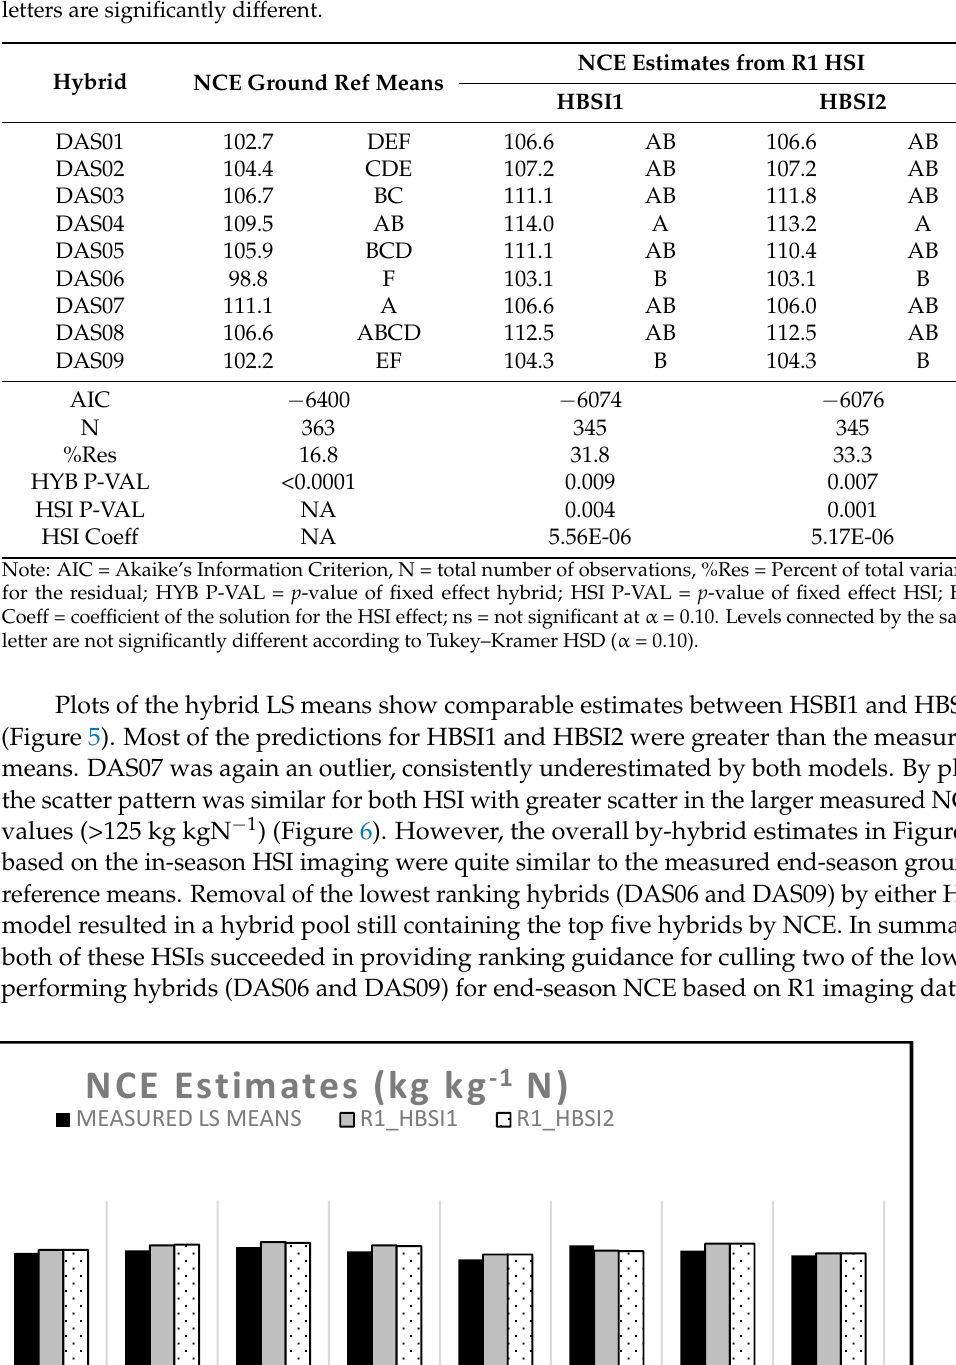
Figure 6. Predicted vs. actual (measured) estimates of NCE with RMSE for each plot. The black line is the 45° reference line (1:1 line). ( A ) Ground reference mixed model; ( B ) R1 HBSI1 model; ( C ) R1 HBSI2 model. Both HBSI1 and HBSI2 are normalized difference vegetation indices with NIR reflec- tance at 855 or 910 nm, respectively. The NIR region is known for detecting variations in cellular structures and plant cavities which vary upon changes in plant vigor or health. These experiments were designed to cause N stress to the maize plants over time. This effect is evident in the low N treatment of our experiment which had significantly lower biomass (TDM at R6), pN, and TNC at R6 as well as numerically lower grain yields. NCE is closely tied to plant health since it is a measure of biomass produced per unit of N. Consequently, this newly identified link between the structural indices (HBSI1 and HBSI2) and NCE is reasonable and supports our hypothesis. An HSI originally developed for biomass detection in cotton [44], MSAVI was later confirmed as predictive of maize biomass [68]. Earlier research [66] found that MSAVI was consistently a good predictor of leaf chlorophyll content in maize and wheat. Under N stress and high density conditions, maize plants are shorter in final height, producing less biomass [69]. Due to the relationship of MSAVI to biomass and chlorophyll, we hy- pothesized a strong relationship to NCE. However, the data did not support this idea. Interestingly, HBSI3, another structural index proposed by [27], differed from HBSI1 and HBSI2 by its reflectance in the green region (550 nm) instead of the NIR portion of the spectrum. The band at 550 nm is known to be responsive to chlorophyll changes [70,71]. Our results showed it to be less predictive of NCE than the other structural indices. Due to the ability of HBSI1 and HBSI2 to differentiate hybrids in NCE at R6 based on mid-season images, further investigation of this promising finding is recommended. Ad- ditional studies with other locations and hybrids for these specific HSI are needed to fully assess their applicability across environments and genotypes. Both HSI identified in this study as good predictors of NCE were based on reflectance of NIR:R. Several NIR:R indi- ces such as NDVI, MSAVI, and OSAVI were also investigated in this research, yet no